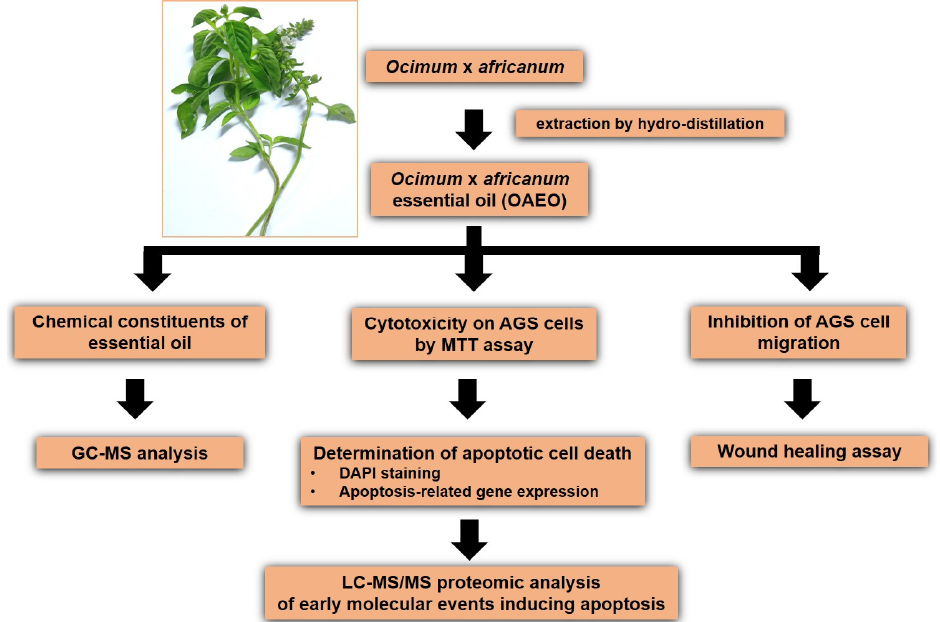
Figure 1. Flow diagram of this study.